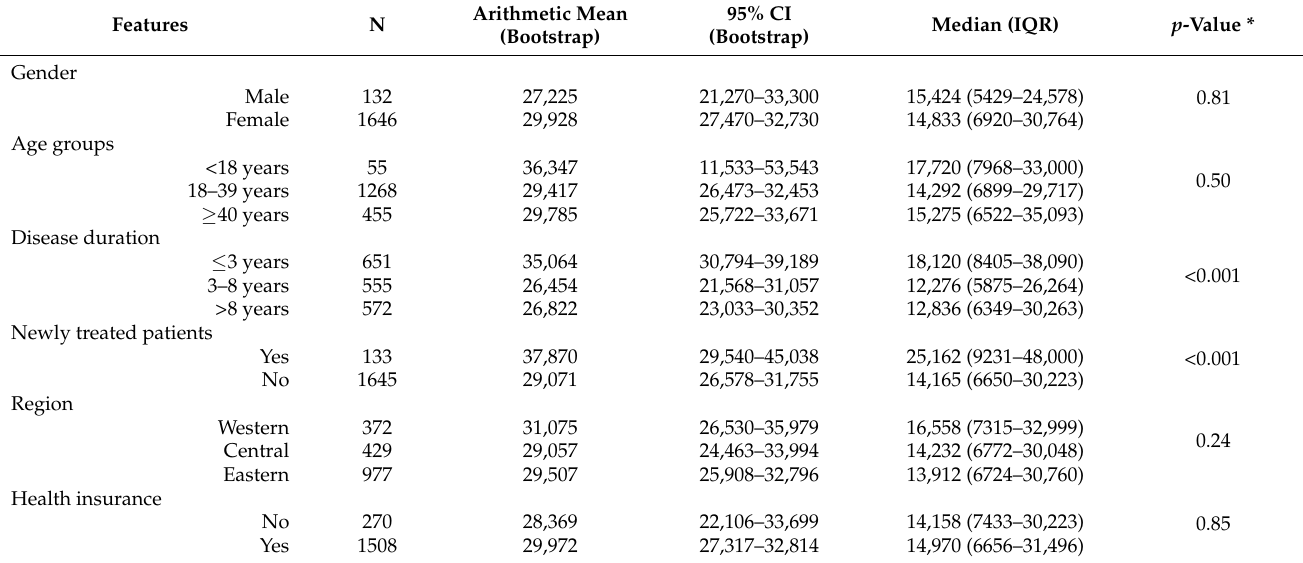
Table 3. Details of the annual direct cost of SLE patients in China (Unit: